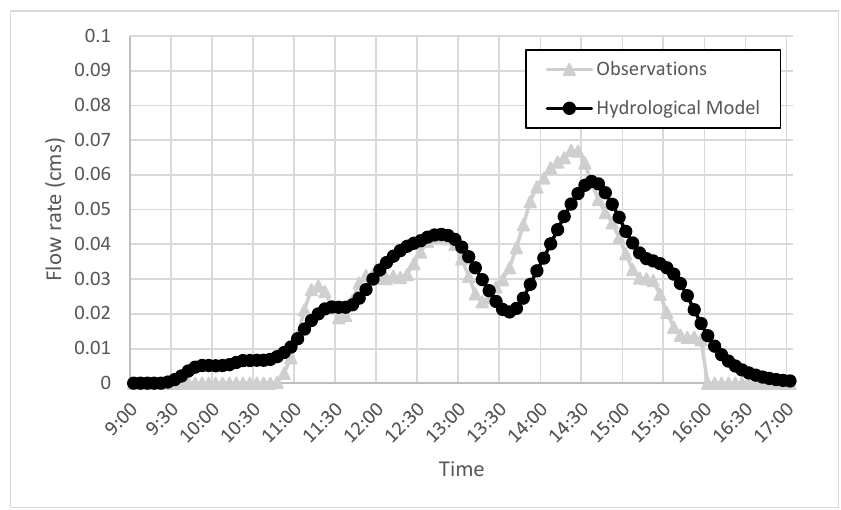
Figure 3. Modeled and observed hydrographs at I5 inlet of storm event on 26 August 2007.